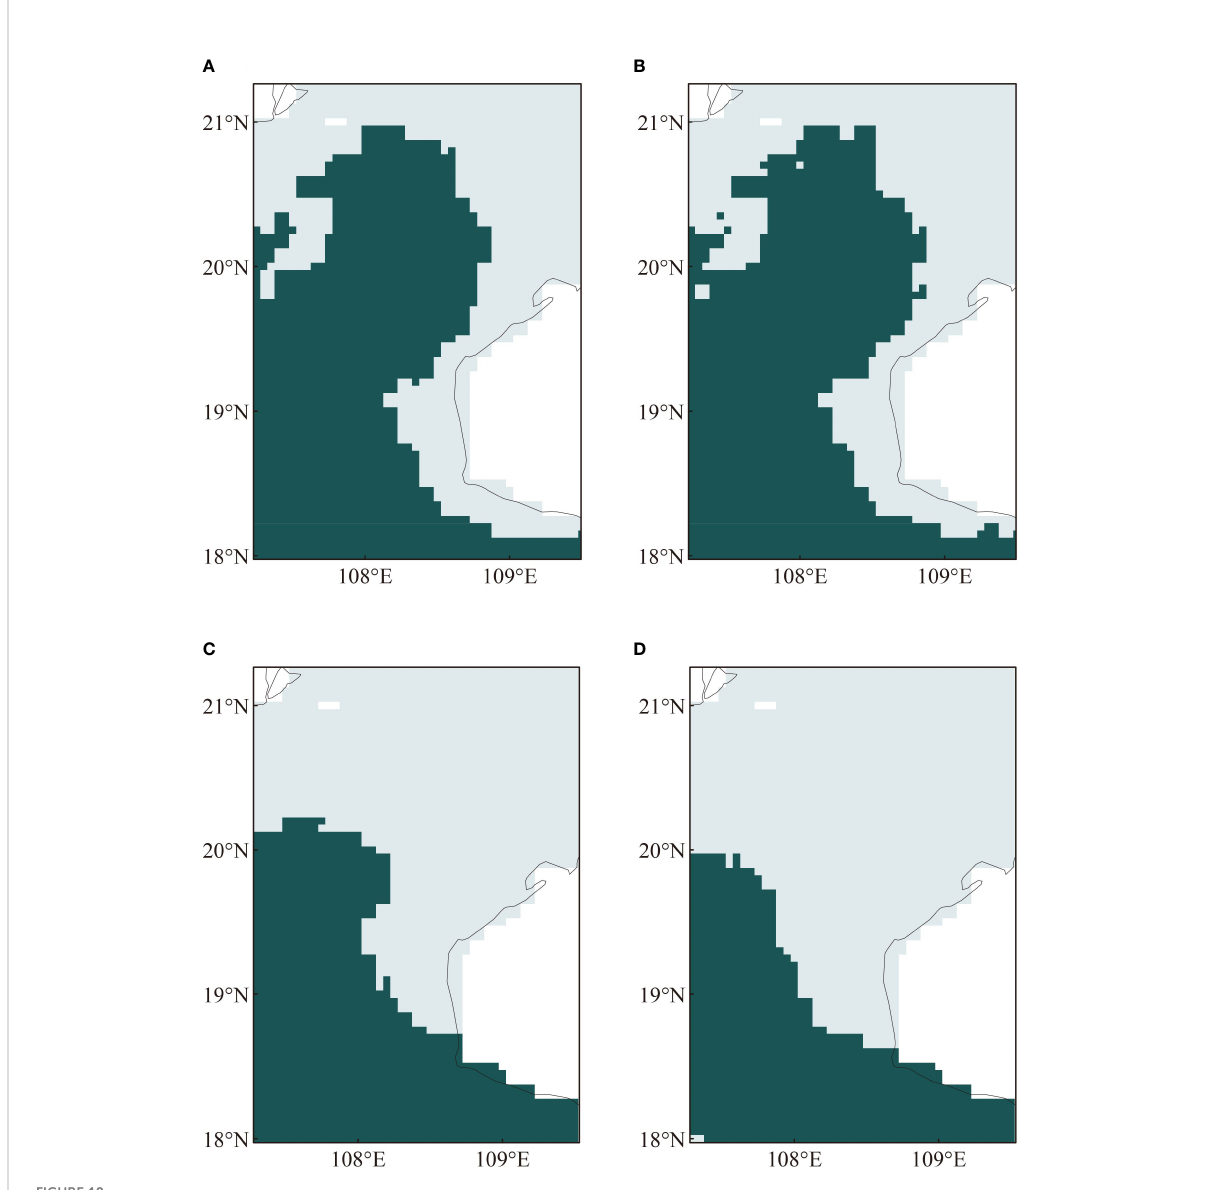
FIGURE 10 Distribution of the most suitable salinity and mixed layer depth combination (darker color) for Trichiurus japonicus in the Beibu Gulf, as projected for the future (in the 2050s and 2090s), under SSP370: (A) mixed layer depth, 2050s; (B) mixed layer depth, 2090s; (C) salinity, 2050s; (D) salinity,